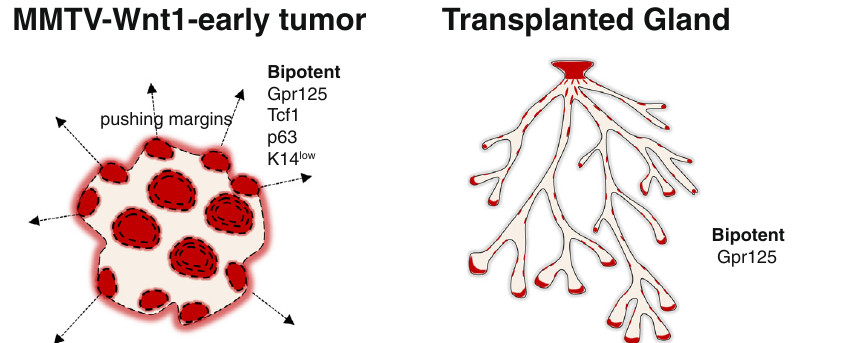
Fig. 8 Schematic of Gpr125 progenitor location, pro fi le, and potency characteristics over the course of mammary development. Gpr125 is expressed ~E15 in a bipotent progenitor population concentrated towards the growing tip of the mammary sprout. Later, ~E18, as lineage segregation ensues, it becomes restricted to basal unipotent progenitors con fi ned to K14 + ;Lgr5 + cells in the nipple region and distal K14-/K18-/p63 + /Tcf1 + cells at ductal tips. Gpr125 is retained in the nipple proximal zone throughout postnatal mammary development. During puberty is strongly expressed in cap cells of terminal end buds during ductal elongation and a population dispersed along the maturing ducts. During pregnancy Gpr125 expression increases in unipotent basal progenitors located at tips of emerging side-branches but is absent from differentiated alveoli. In MMTV-Wnt1 early tumors bipotent Gpr125 + K14-;K18- progenitors are expanded and located in large islands and at pushing margins. In transplanted glands Gpr125 progenitors regain dependency on cell-matrix attachment for progenitor phenotype cap cells and underlying body cells. However, as is the case for and function. Several adhesion-GPCRs, for example, Gpr56/ most adhesion GPCRs, its potential ligands, role in cell-cell Adgrg1, which functions in cell guidance/adhesion, have been adhesion, and downstream signaling pathway remain obscure. shown to interact directly with cell matrix proteins and regulate Our bulk RNA-seq data indicate that Gpr125 + cells at the basement membrane organization 53 . Gpr125, is structurally nipple-proximal end of the gland are engaged in chemo-repulsion related to Ig-CAMs, and localizes to basolateral borders between and the formation of cell surface structures associated with cell